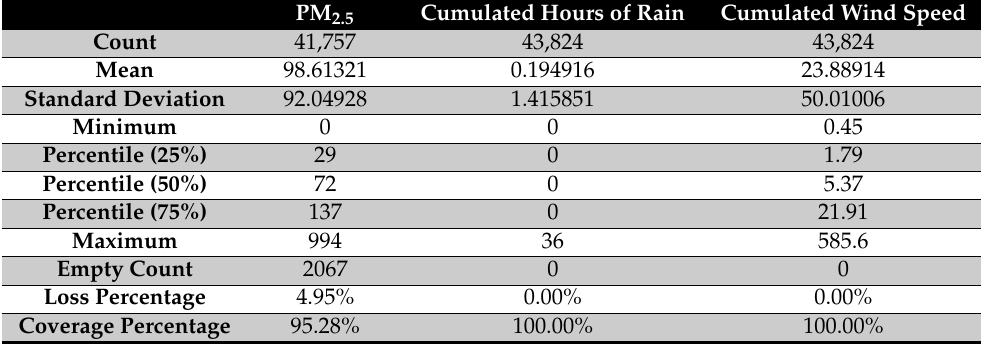
Table 2. Beijing, China dataset